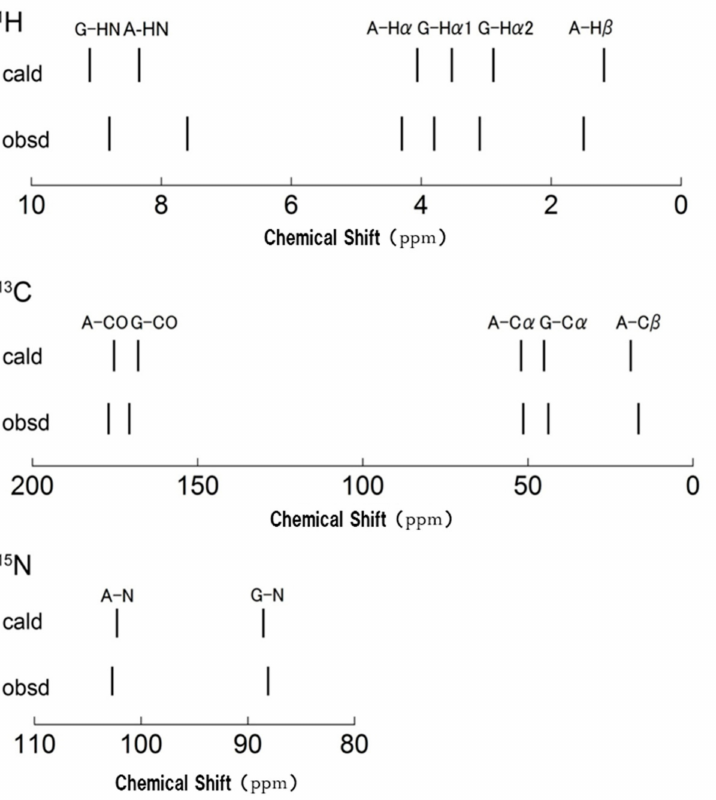
Figure 11. The stick spectra for the 1 H, 13 C, and 15 N chemical shifts were calculated for (AG) 15 with silk I structure together with the observed chemical shifts [86]. The reference chemical shift was shown to be the mean of the calculated and observed chemical shifts for all peaks. The values were 30.51 ppm, 171.31 ppm, and 197.22 ppm for 1 H, 13 C, and 15 N nuclei, respectively. Reprinted with permission from ref.